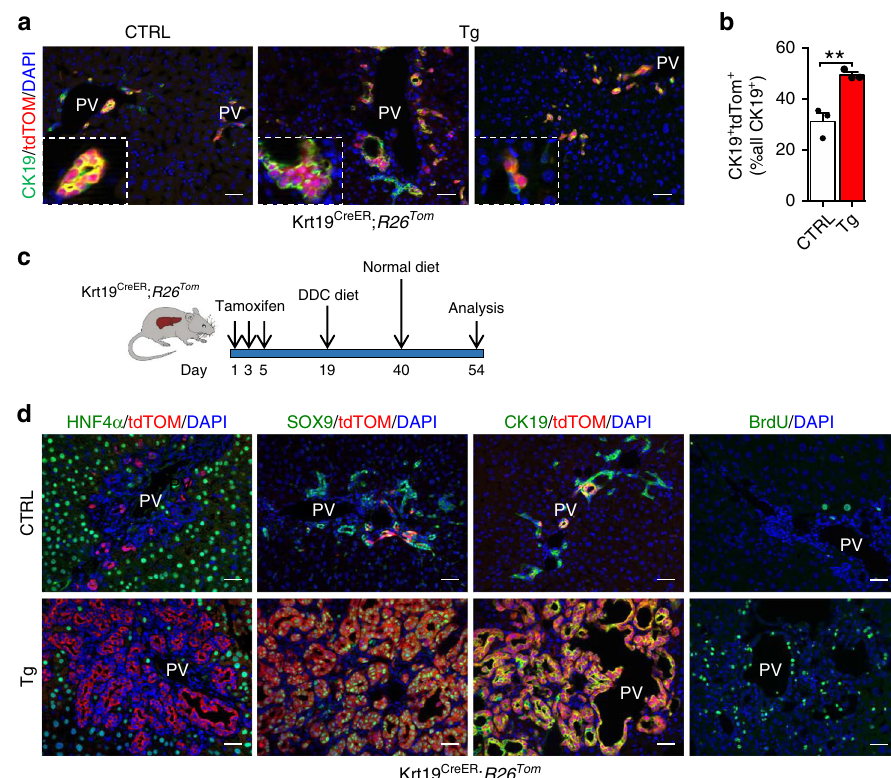
Fig. 6 TFEB overexpression in progenitor/cholangiocytes gives rise to ectopic ductal structures. a Representative image of CK19/tdTom dual immuno fl uorescence of CTRL and TFEB OE liver 4-weeks after tamoxifen injection. Scale bar 50 μ m. b Quanti fi cation of CK19 + biliary epithelial cells that were tdTom + ( n = 3 biological replicates/ n = 5 different images/sample). Data are represented as mean ± SEM. ** p ≤ 0.01 two-tailed Student ’ s t -test. c Experimental strategy to lineage trace biliary epithelial cells on a background of liver injury. d tdTom/HNF4 α , tdTom/SOX9, and